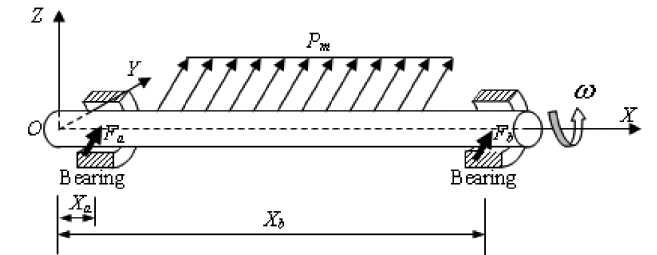
Fig. 1. A continuum rotor-bearing system excited by distributed electromagnetic load.